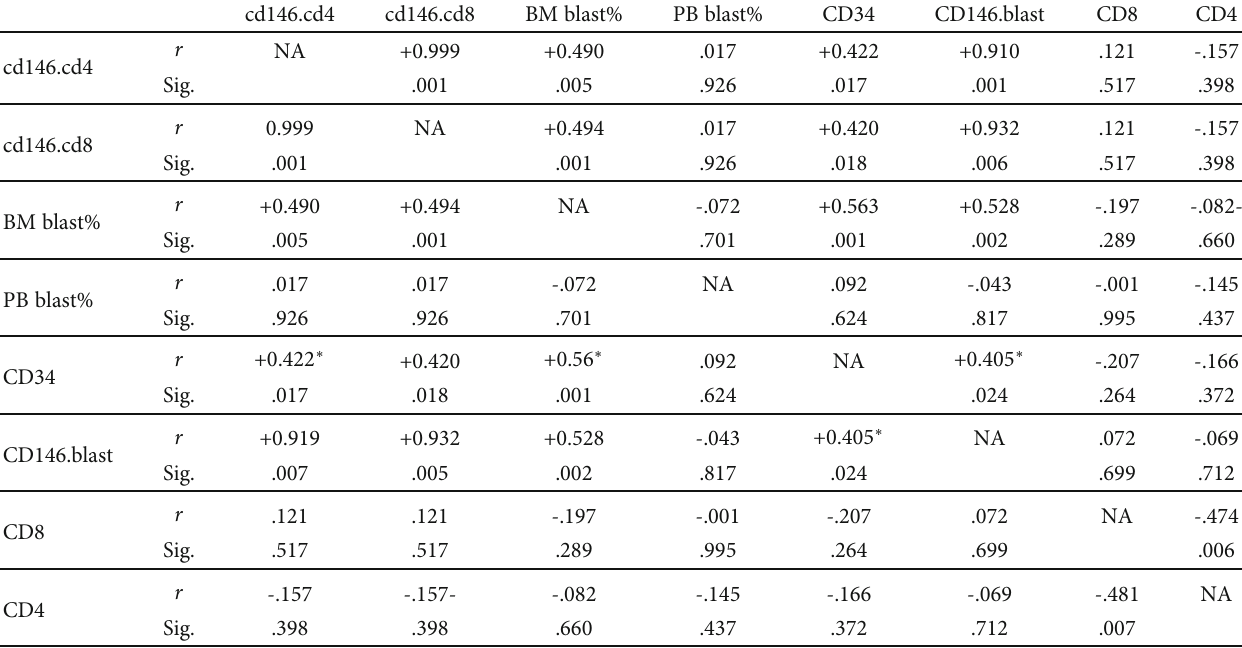
Table 3: Relations between CD146 and di ff erent fl ow cytometric immune cells and blasts of ALL.